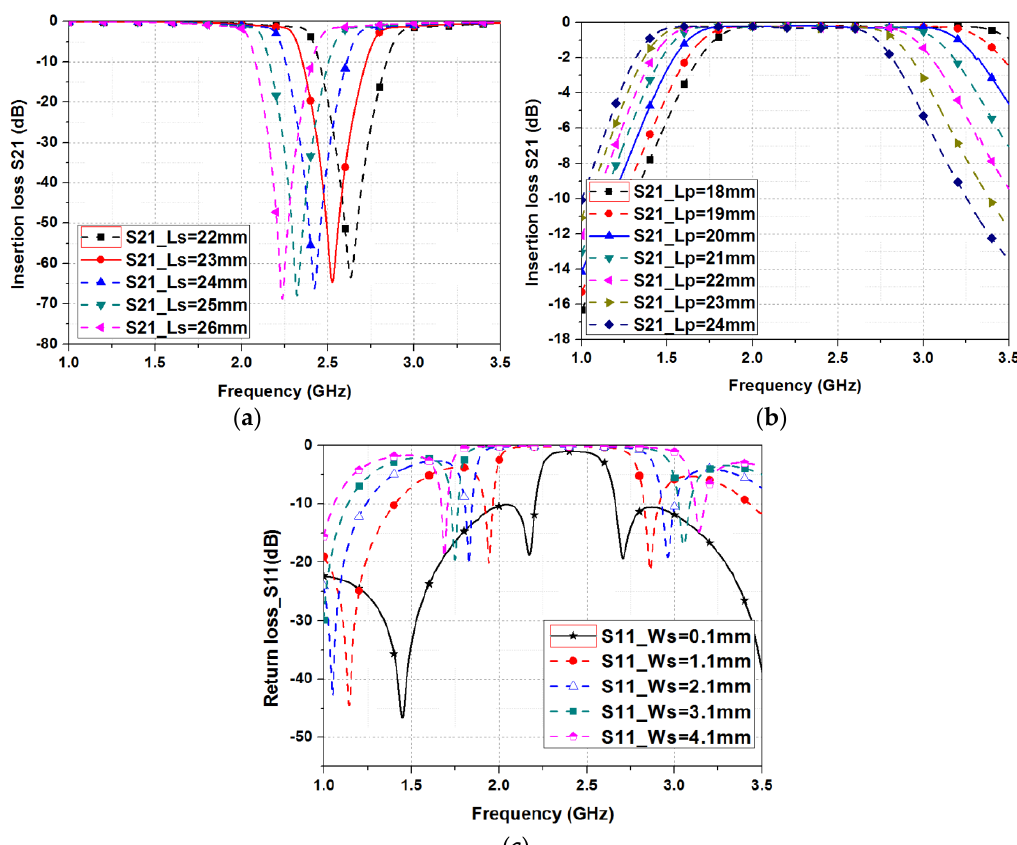
Figure 2. Simulated S 21 of the proposed filter for: ( a ) Different L r ; ( b ) different L s ; ( c ) different L c .